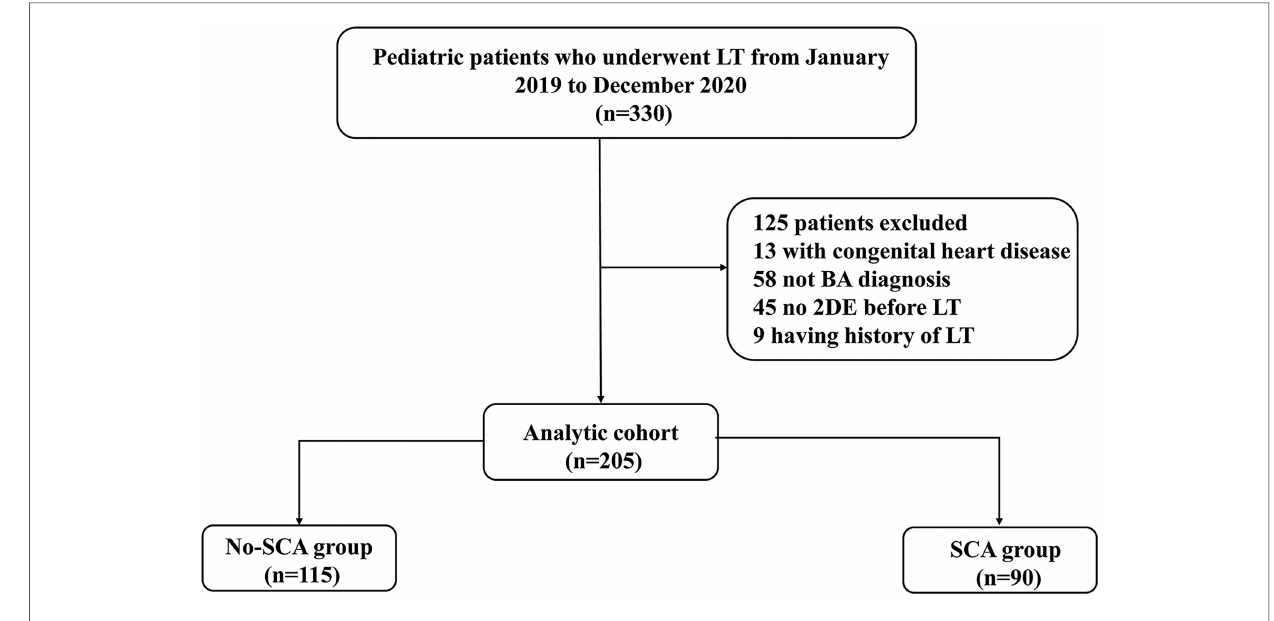
FIGURE 1 Study fl ow